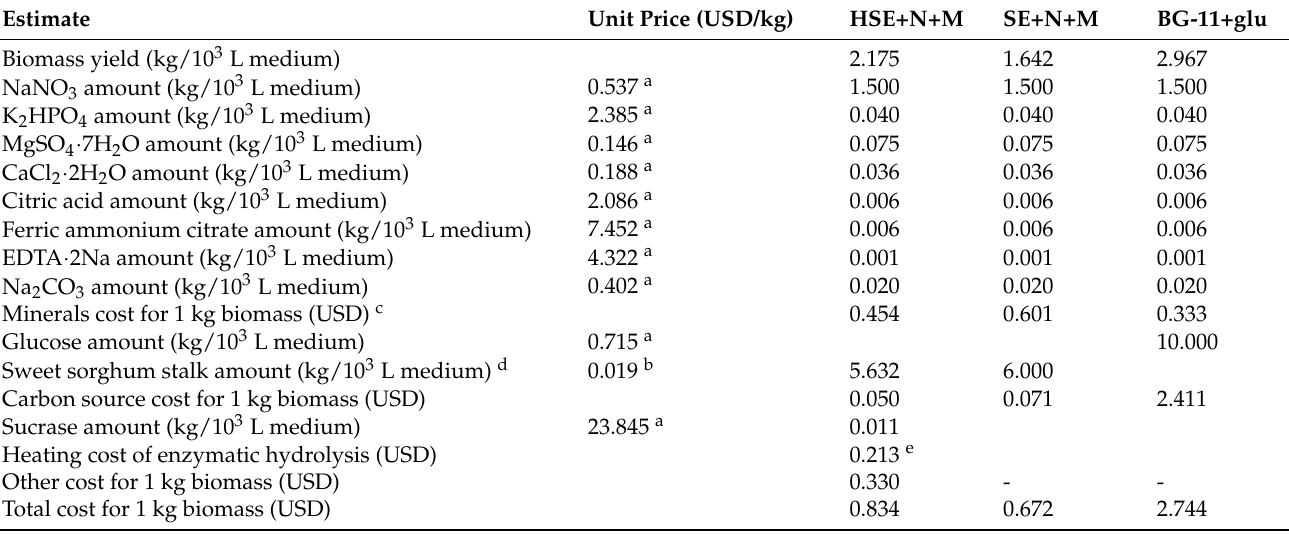
Table 5. Cost comparison of